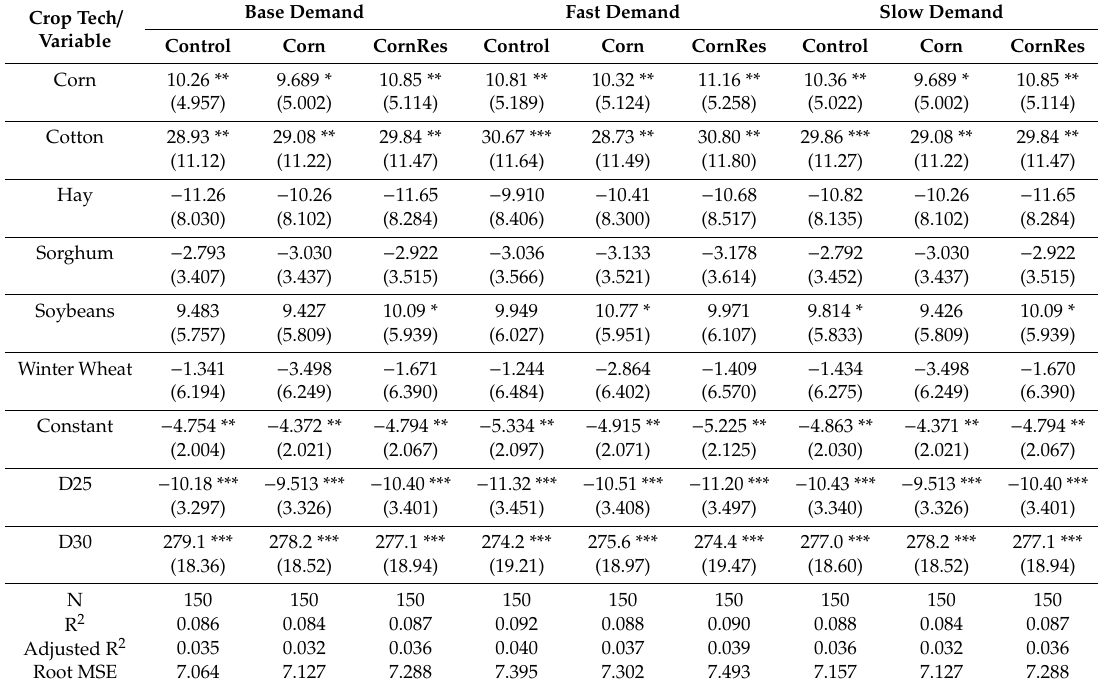
Table 9. Crop production land regression